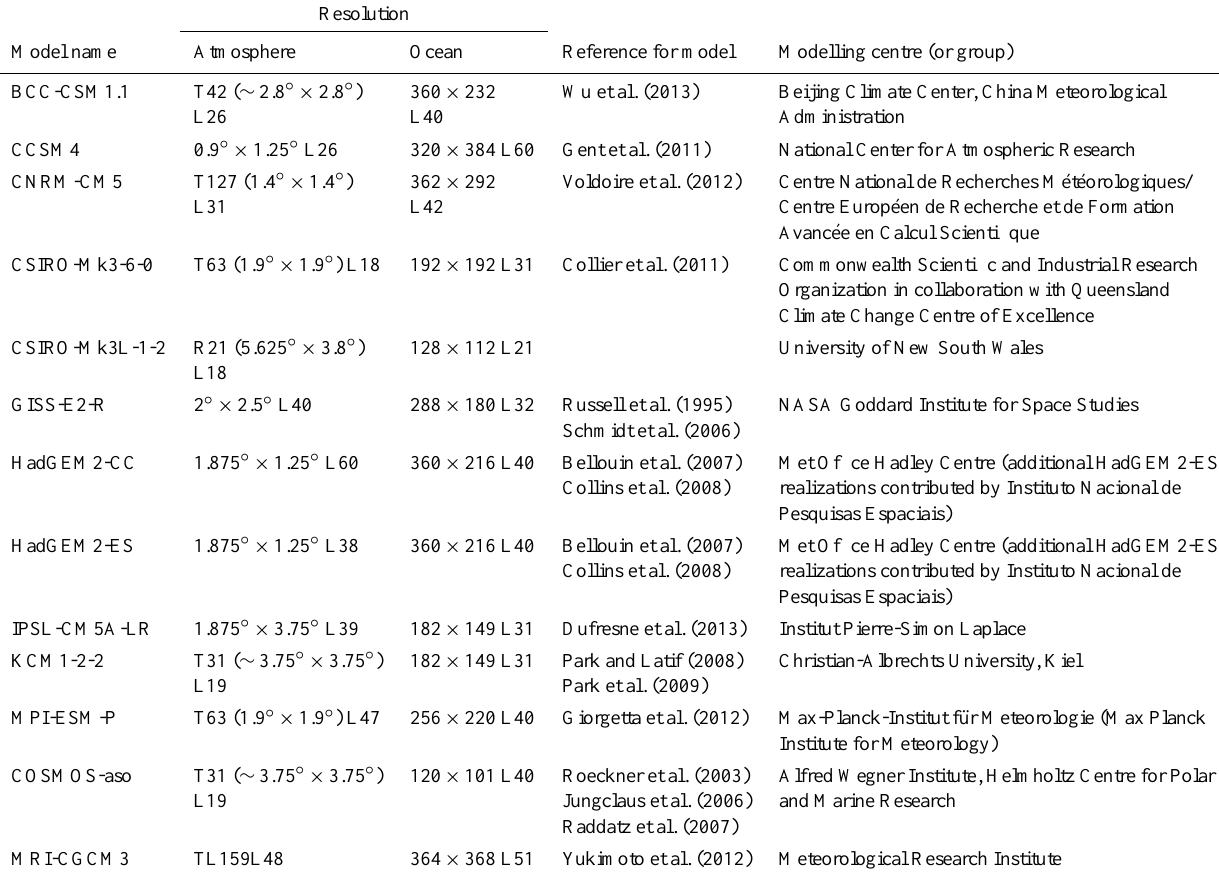
Table 2. List of the models in